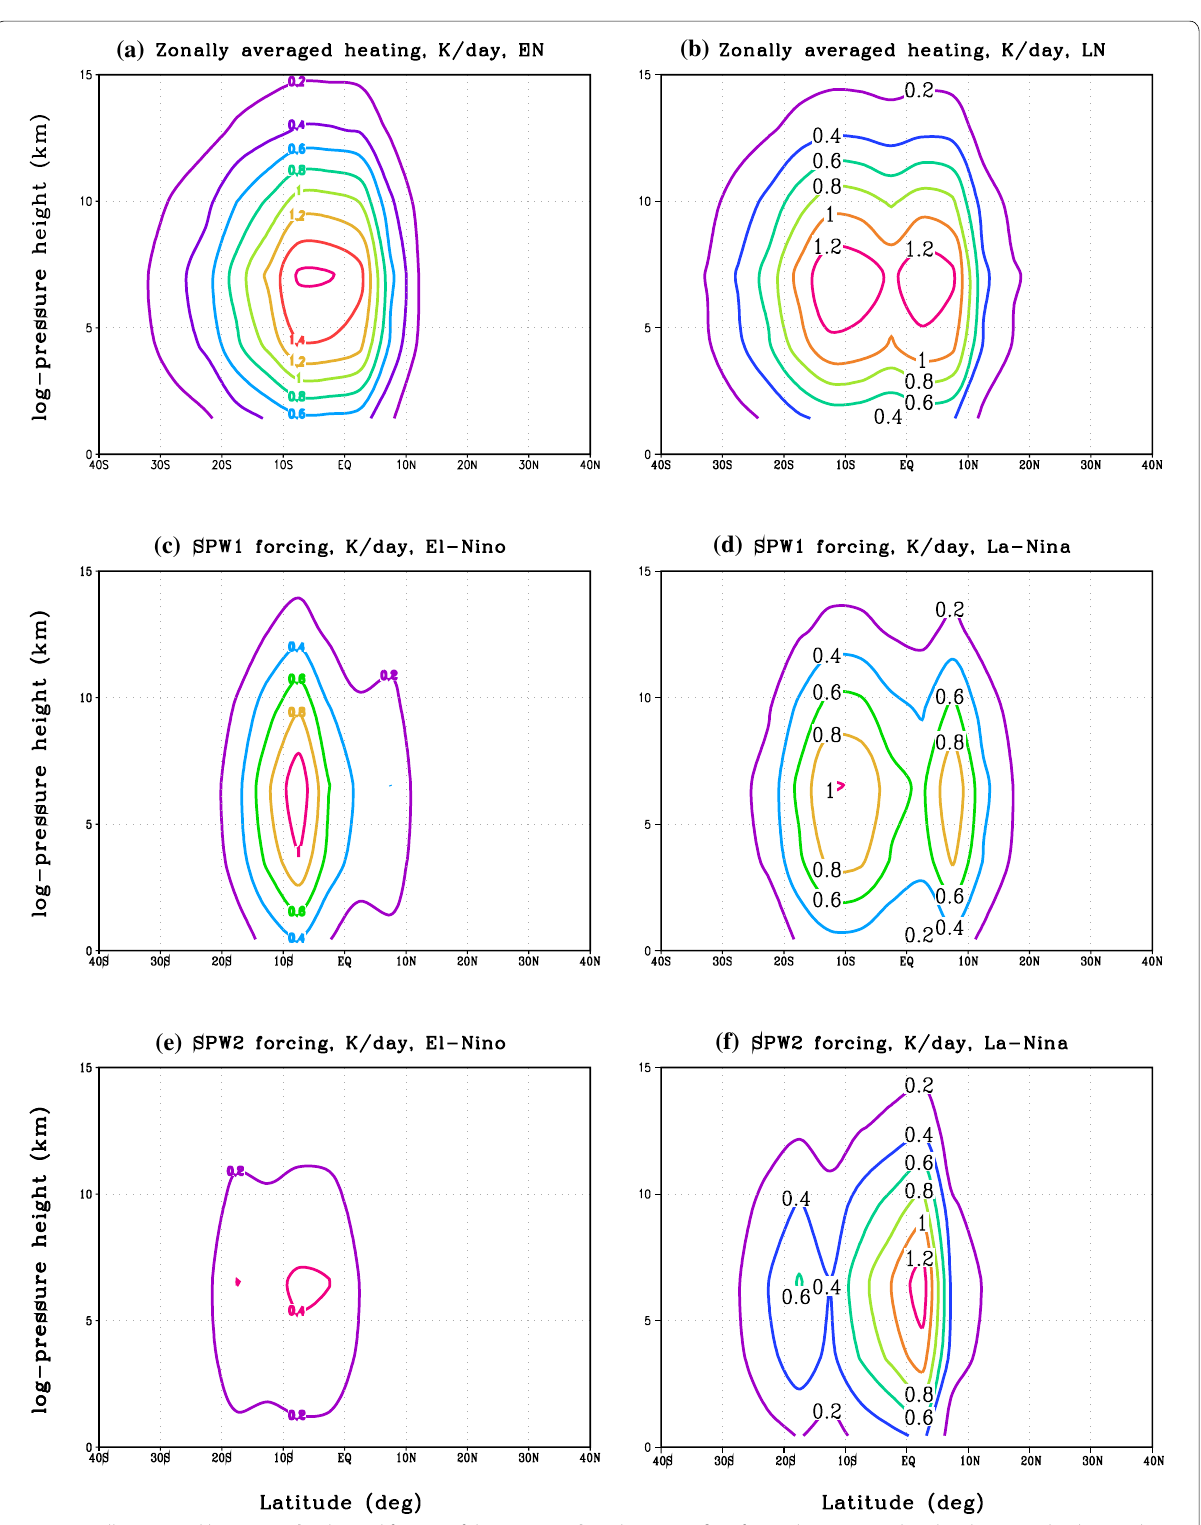
Fig. 2 Zonally averaged heating ( a , b ); thermal forcing of the SPW1 ( c , d ) and SPW2 ( e , f ). Left panels correspond to the El Niño and right panels to the La Niña